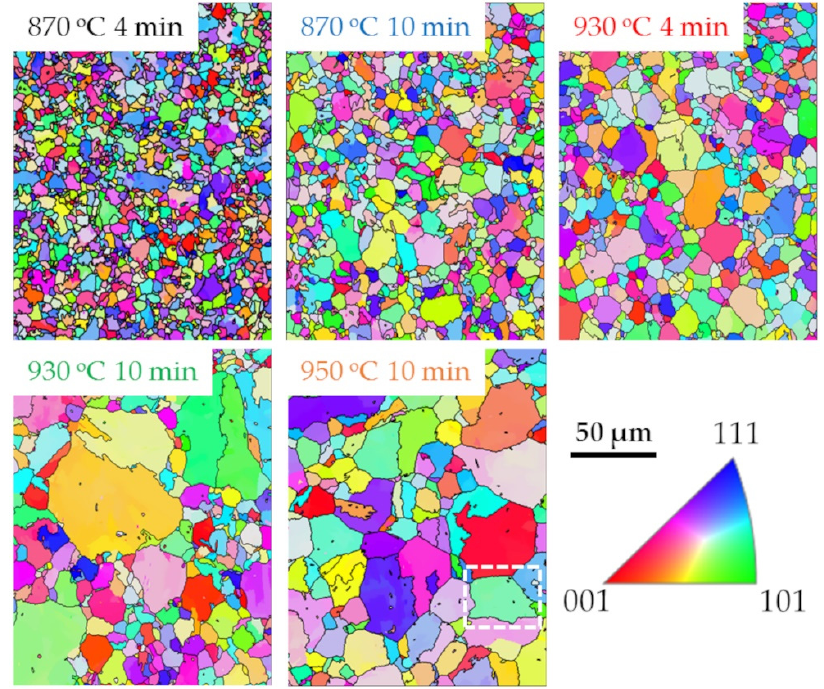
Figure 2. Reconstructed EBSD inverse pole figure maps of the prior austenite grains using the inverse pole figure maps of the five heat-treated martensitic steel (shown in Figure 1) and the associated color-coded stereographic triangle. The prior austenite grain identified in the bottom right of Figure 1 is highlighted with a dashed box in the IPF map for 950 °C 10 min heat-treated material.